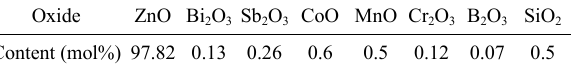
Table 2 Slurry composition for varistor tape casting Slurry component Content (wt%) Ceramic powder